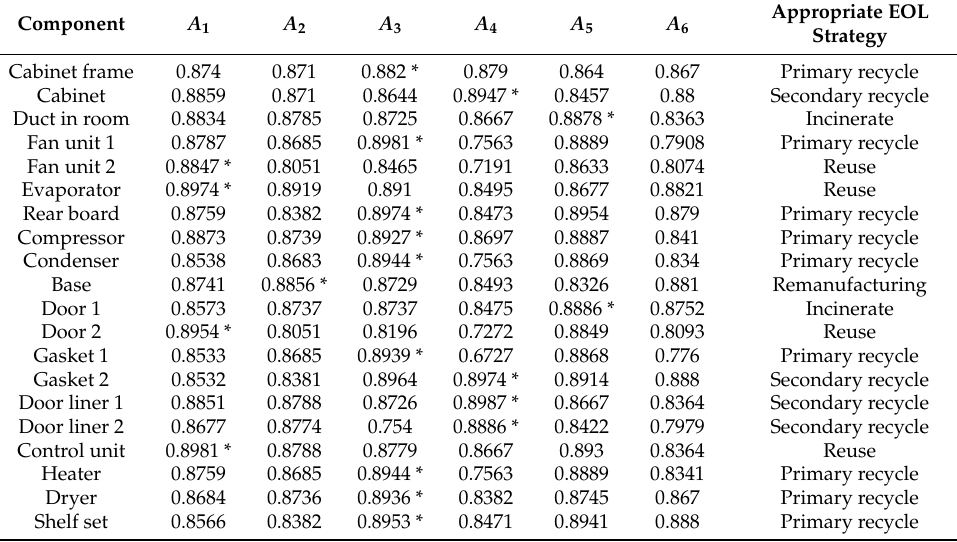
Table 12. Refrigerator component relevant closeness RC and appropriate EOL